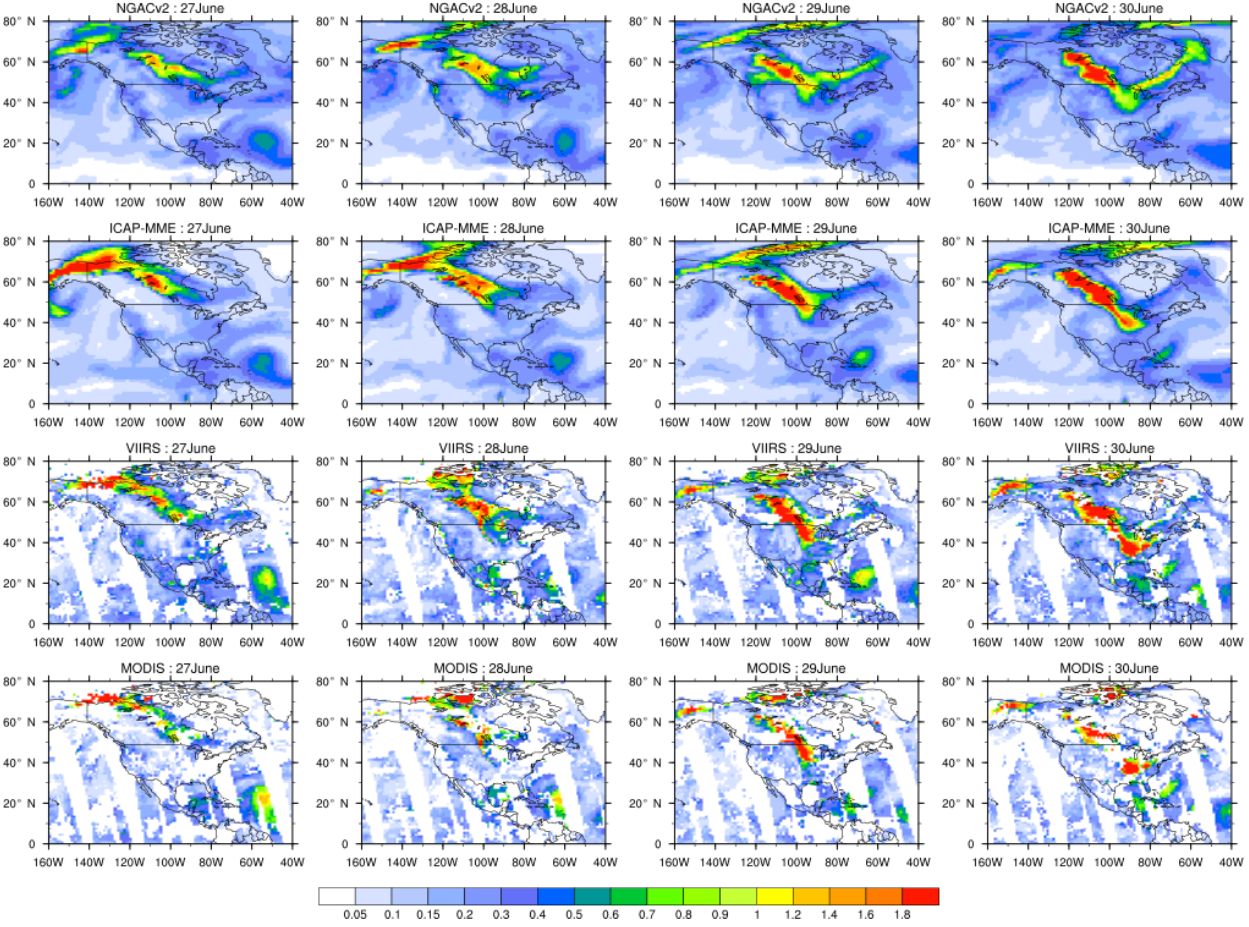
Figure 3. Smoke event of 27 June to 6 July 2015 from NGACv2 and ICAP forecasts and VIIRS and MODIS satellite